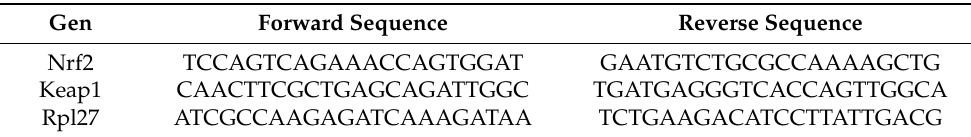
Table 1. Primer sequences for expression of Nrf2 and Keap1